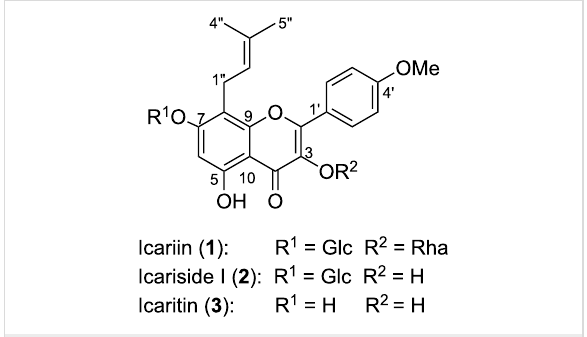
Figure 1: Structures of icariin ( 1 ), icariside I ( 2 ) and icaritin ( 3 ).